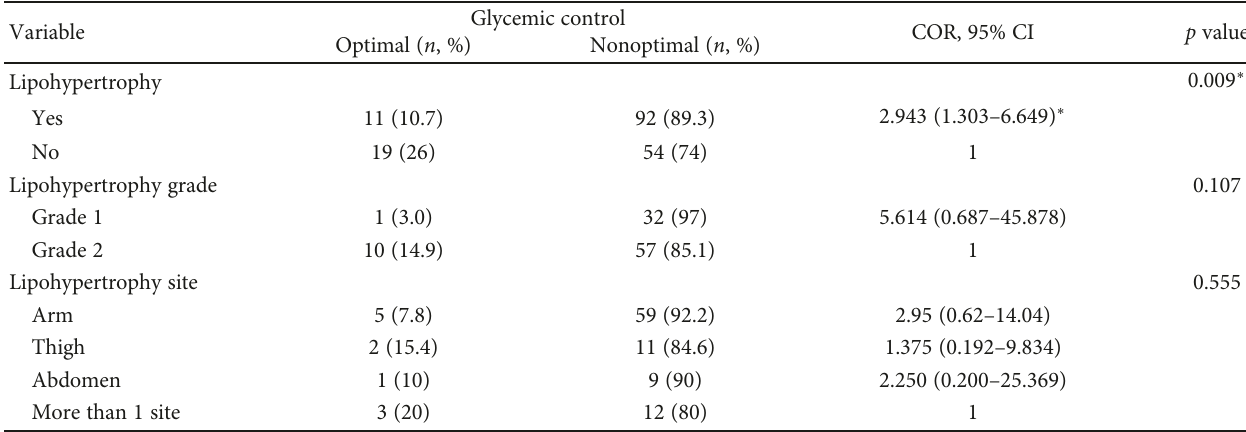
Table 2: E ff ect of lipohypertrophy on glycemic control for type 1 diabetic